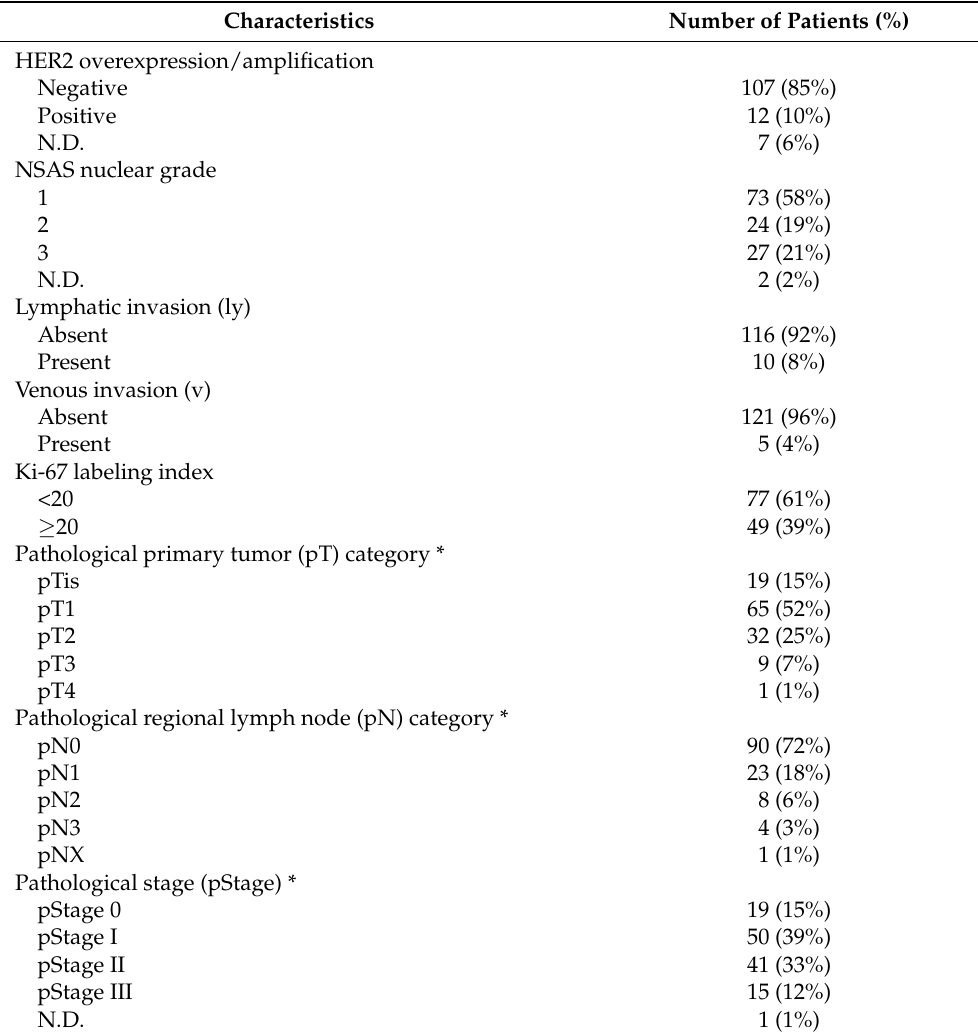
Table 1. Cont. Characteristics Number of Patients